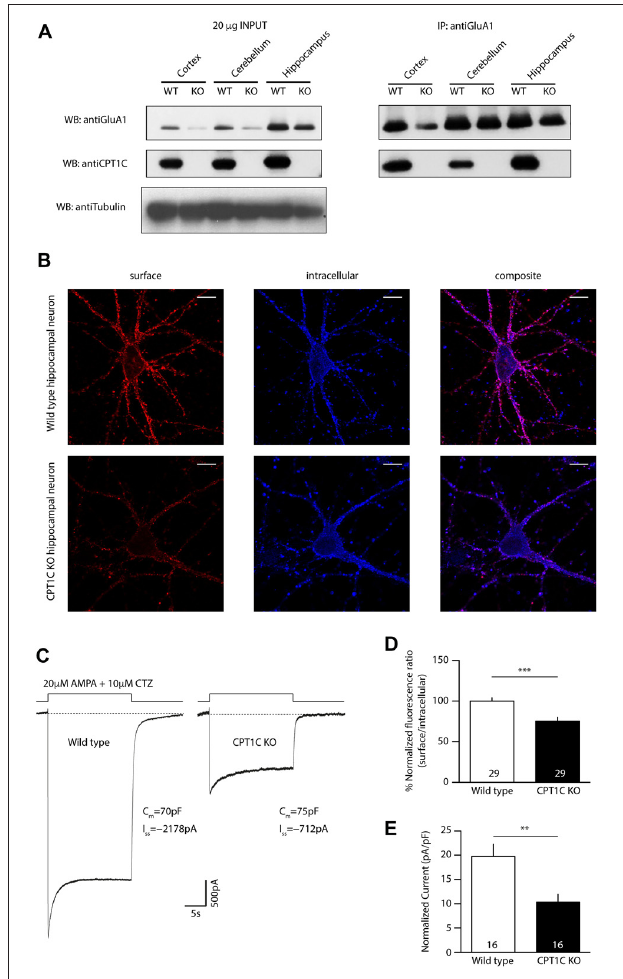
FIGURE 1 | Carnitine palmitoyltransferase 1C (CPT1C) absence in knockout (KO) animals translates into a lower AMPAR expression at neuronal surface. (A) Coimmunoprecipitation of GluA1 and CPT1C from cortex, cerebellum and hippocampal tissue of wild type (WT) and CPT1C KO showing GluA1-CPT1C interaction in all tested brain areas. (B) Representative single confocal images of immunofluorescence (IF) of 11 days in vitro (DIV) hippocampal pyramidal neurons in culture from WT (upper images) and CPT1C KO (lower images) animals. Surface GluA1 (Alexafluor 555; red signal) and intracellular GluA1 (Alexafluor 647; blue signal) is shown. (C) Examples of somatic currents evoked by 20 µ M AMPA +10 µ M cyclothiazide during a 20 s fast application pulse for WT (left trace) and CPT1C KO (right trace) hippocampal pyramidal neurons. Two neurons with similar cell capacitance are shown. (D) Quantification of endogenous somatic GluA1 surface to intracellular ratio from pyramidal cells in culture. GluA1 ratio was diminished in neurons from CPT1C KO animals compared with WT ( ∗∗∗ p = 0.0003; Mann-Whitney-U-test). Numbers in bars indicate the number of neurons analyzed. (E) CPT1C KO pyramidal neurons display lower current density—measured at the steady state current ( ∗∗ p = 0.0035; Mann-Whitney-U-test). Numbers in bars denote the number of recorded